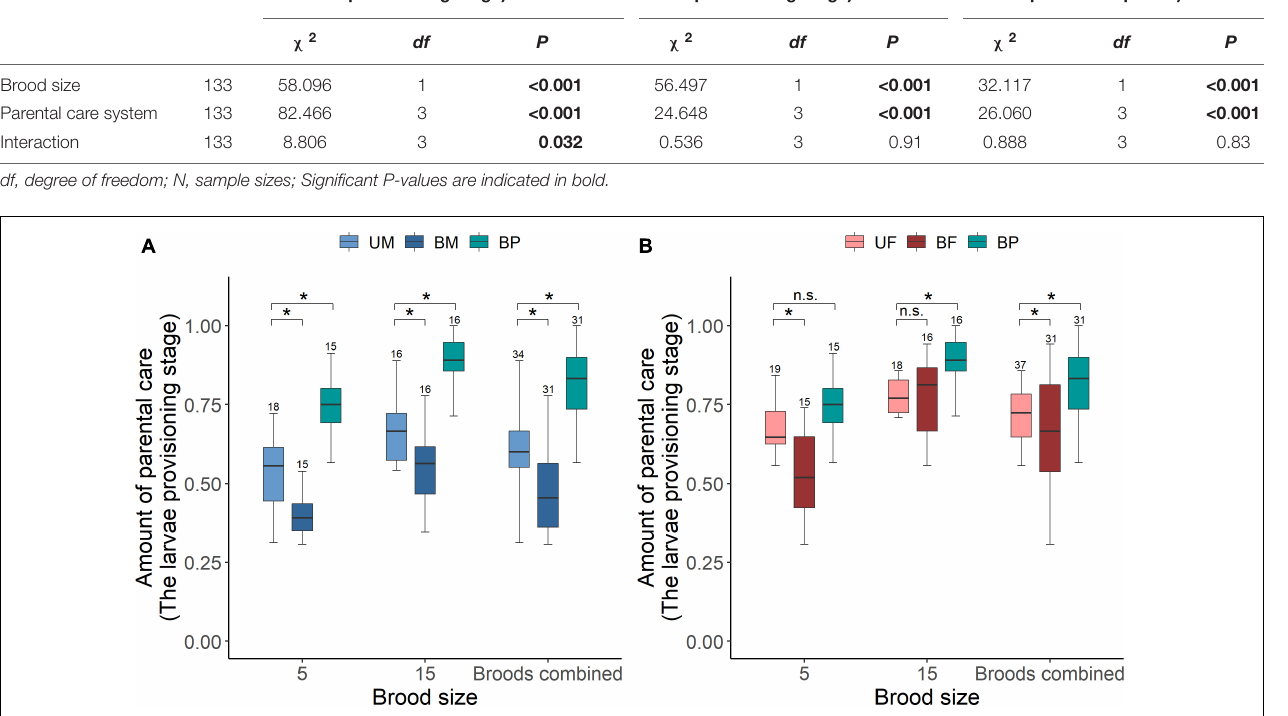
TABLE 2 | Effects of parental care system (uniparental male, uniparental female, biparental male, biparental female) and brood size (5 vs. 15), and their interaction on the amount of parental care and weight change of burying beetle parents during the larvae provisioning stage and the entire reproductive period in the first breeding. Amount of parental care (The larvae Weight change (The larvae Weight change (The entire Factor N provisioning stage) provisioning stage) reproductive period)